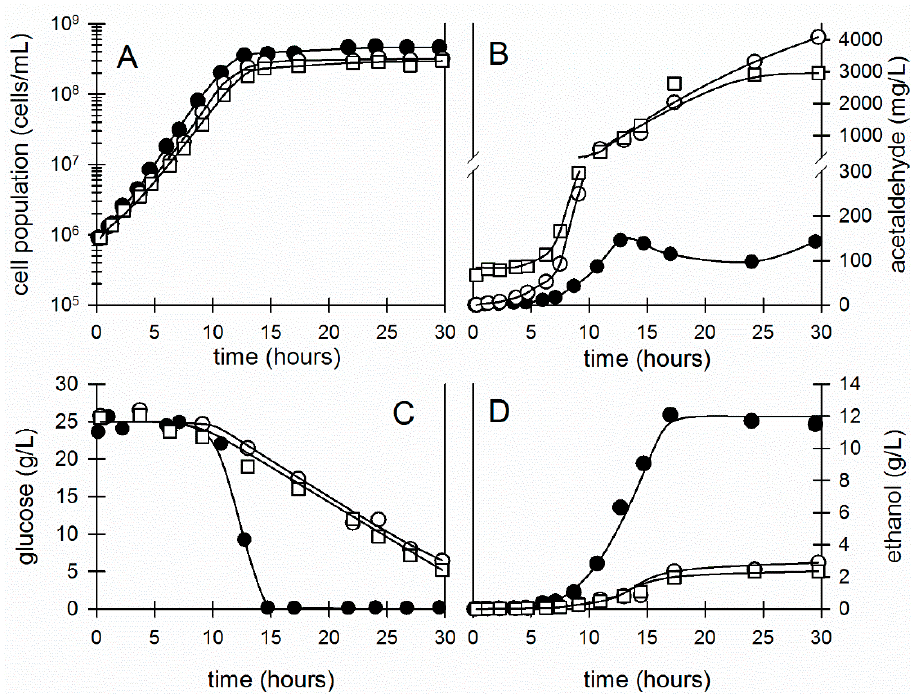
Figure 5. Effect of added acetaldehyde (90 mg/L) on the growth and metabolism of Z. mobilis following a transfer from anaerobic to aerobic conditions; • control culture (anaerobic); aerobic culture; (cid:3) aerobic culture with added acetaldehyde. ( A ) Growth; ( B ) acetaldehyde; ( C ) glucose; ( D ) produced ethanol.